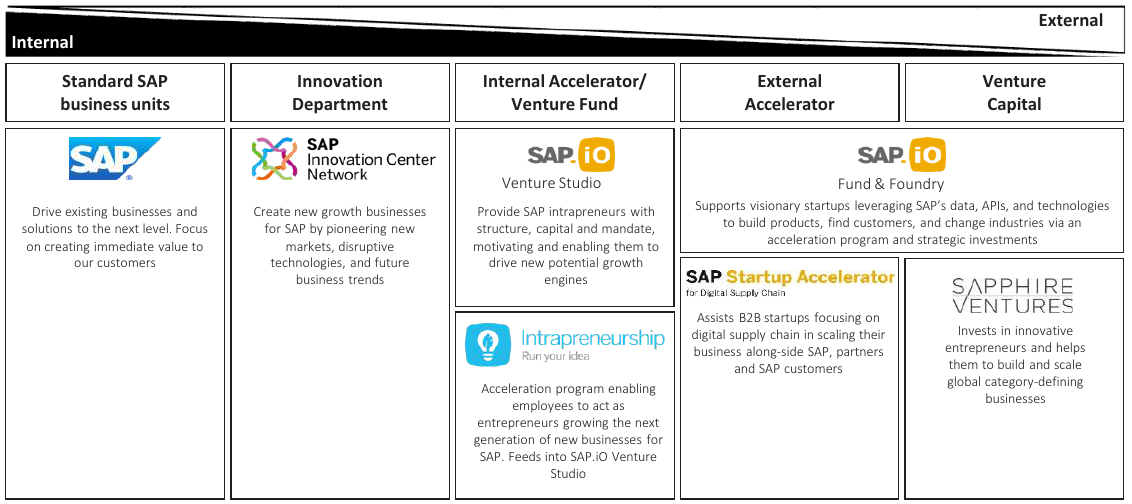
Figure 1 maps the various innovation, incubation and venturing initiatives at SAP along the locus